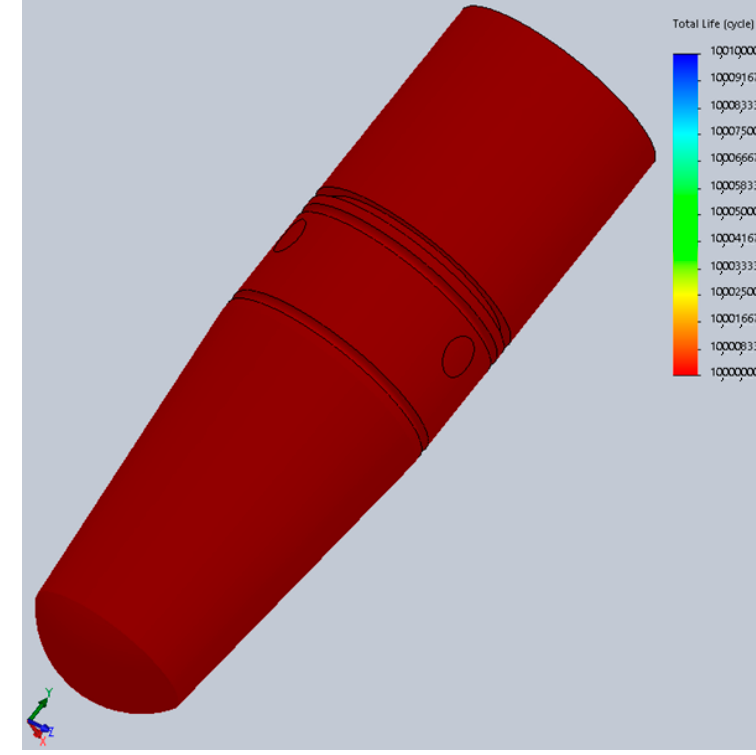
Figure 15. Life expectancy of tested implant prototype (FEA) .